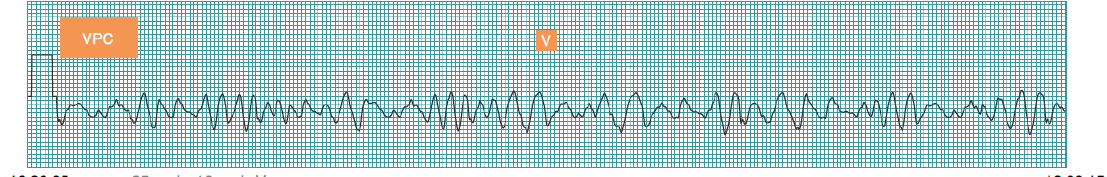
Figure 6. The misclassified VF rhythm to a VPC beat. Table 6. The proposed integrated algorithm evaluation time in PC and smartphone for the MIT-BIH Arrhythmia database.